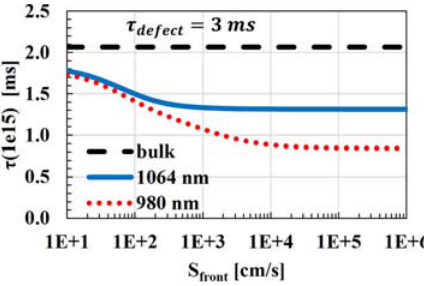
Fig. 5. Measured effective lifetime at D n avg =10 15 cm (cid:1) 3 is inde- pendent of the front surface recombination velocity, S front , in its typicalrange. N dop =10 16 cm (cid:1) 3 , t defect =3ms, F =2 (cid:3) 10 19 cm (cid:1) 2 s (cid:1) 1